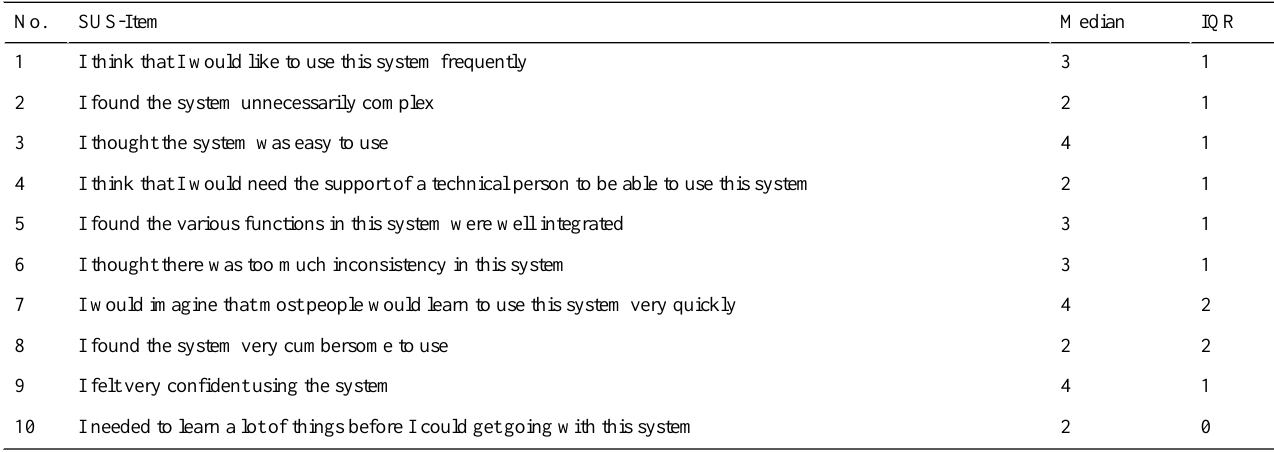
Table 1. Median and IQR for all SUS items (original scores), based on N=5 interviews.